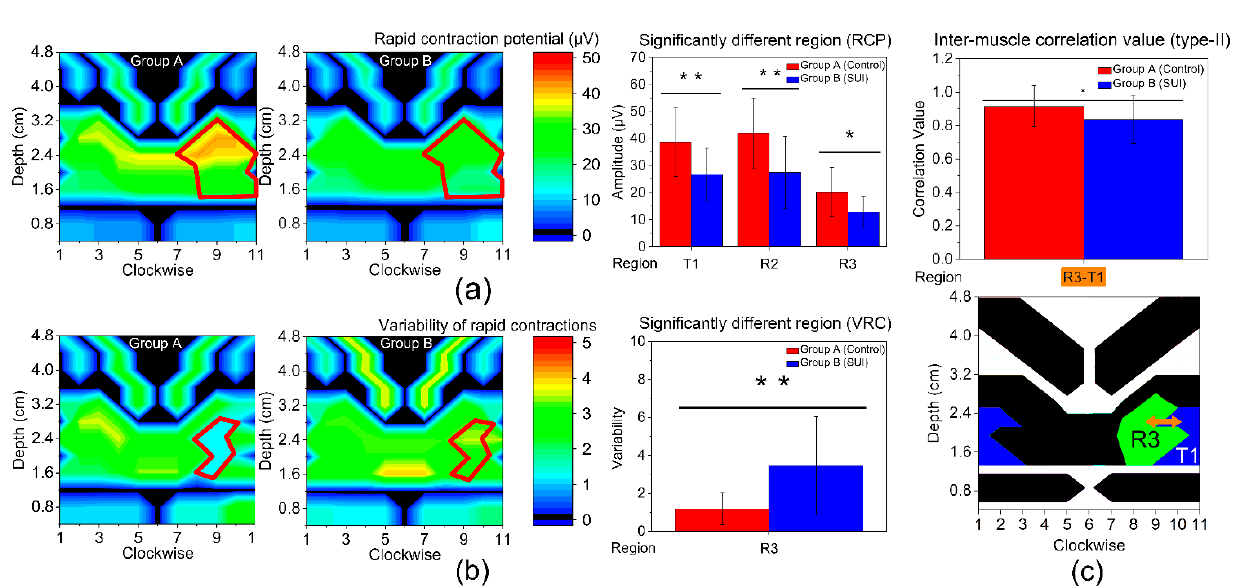
Figure 5. Type-II muscle function evaluation of two groups. ( a ) Rapid contraction potential (RCP) and ( b ) variability of rapid contractions (VRC) for each diagnosis group. From left to right: amplitude results contour map of group A; amplitude results contour map of group B (red frame marks the significantly different regions); significantly different regions of parameter, including T1, R2, R3. According to the ultrasonic-assisted measurement, the muscle relationship corresponding to these regions are: T1: US; R2: PC; R3: PR. Asterisk indicates significant difference. *: p < 0.05; **: p < 0.01. ( c ) Inter-region correlation value of type-II muscle fiber. The upper graph is the significantly different region of correlation value and the lower is the location diagram.